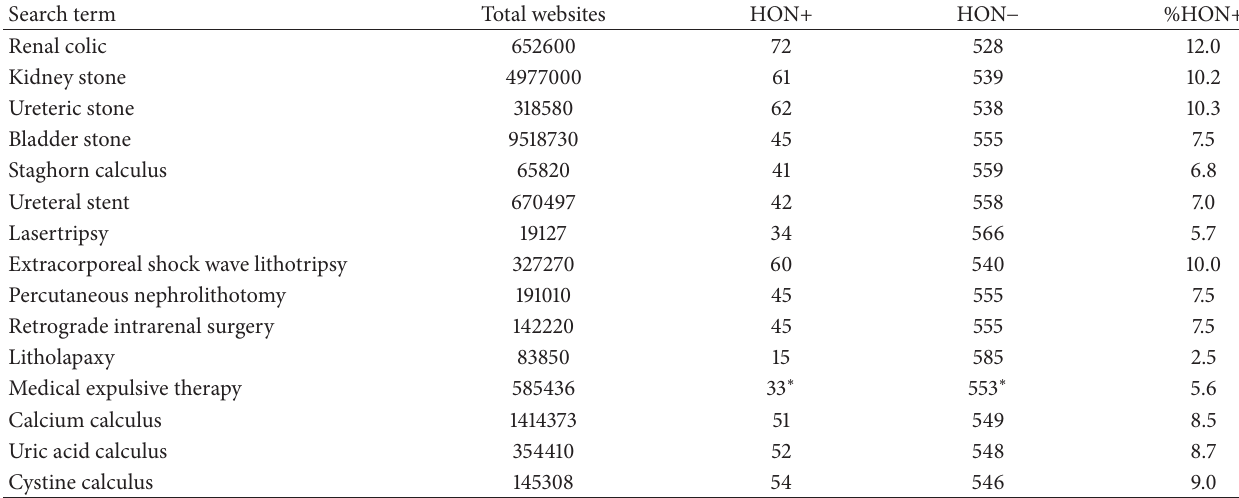
Table 2: Rates of HON-accredited websites among the search terms.